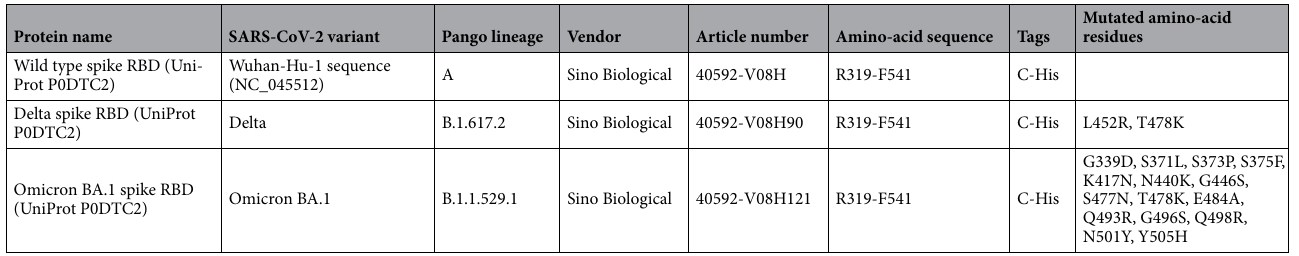
Table 1. Summary of SARS-CoV-2 spike RBD reagents used in this study.